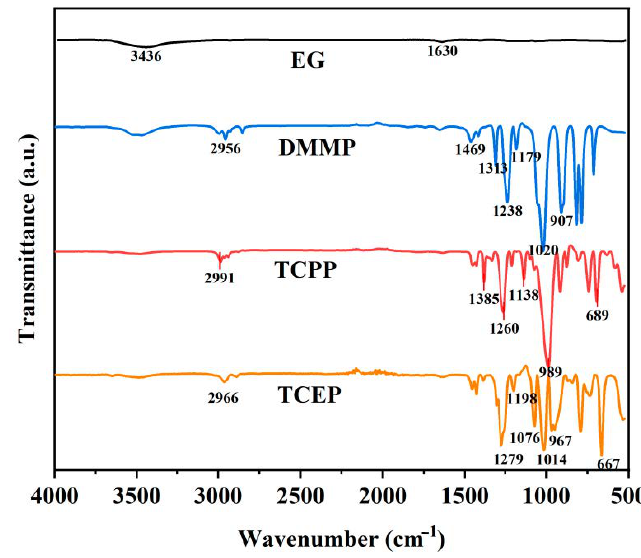
Figure 2. FTIR spectra of TCEP, TCPP, DMMP, and EG. As depicted in Figure 3, the neat microcellular polyurethane elastomer (MPUE) showed peaks of N-H bonding in amide at 3314 cm − 1 (stretching) and 1537 cm − 1 (bend- ing). The peaks at 2933 cm − 1 and 2859 cm − 1 were attributed to CH 2 and CH 3 stretching vibration, while the one at 1415 cm − 1 represented the bending vibration of CH 2 and CH 3 . The peaks at 1727 cm − 1 and 1703 cm − 1 indicated the free and hydrogen bonding restricted C=O groups, respectively. The peaks at 1602 cm − 1 , 1219 cm − 1 , and 1097 cm − 1 corresponded to stretching vibration of the benzene backbone, C-O bonding in ester, and C-O-C bonding in polyether, respectively. Those characteristic peaks for polyurethane prove the formation of MPUE [44]. FTIR spectra also proved the formation of MPUE/flame retardant composite elastomers (FR/MPUE). MPUE/TCEP displayed peaks at 1041 cm − 1 and 672 cm − 1 , which corresponded to phosphate and C-Cl. MPUE/TCPP displayed peaks at 1371 cm − 1 , 1050 cm − 1 , and 690 cm − 1 , which corresponded to isopropyl, phosphate, and C-Cl, respectively. MPUE/DMMP and MPUE/EG/DMMP-5 displayed peaks at 1460 cm − 1 , 1306 cm − 1 , and 913 cm − 1 , which corresponded to P-C and/or P-CH 3 . These phenomena indicated that those liquid flame retardants were physically dispersed in the MPUE matrix, without a participating chemical reaction. Noticeably, the absorption peak of -OH groups in EG shrank in MPUE/EG/DMMP-5, implying that the hydroxyl groups on EG